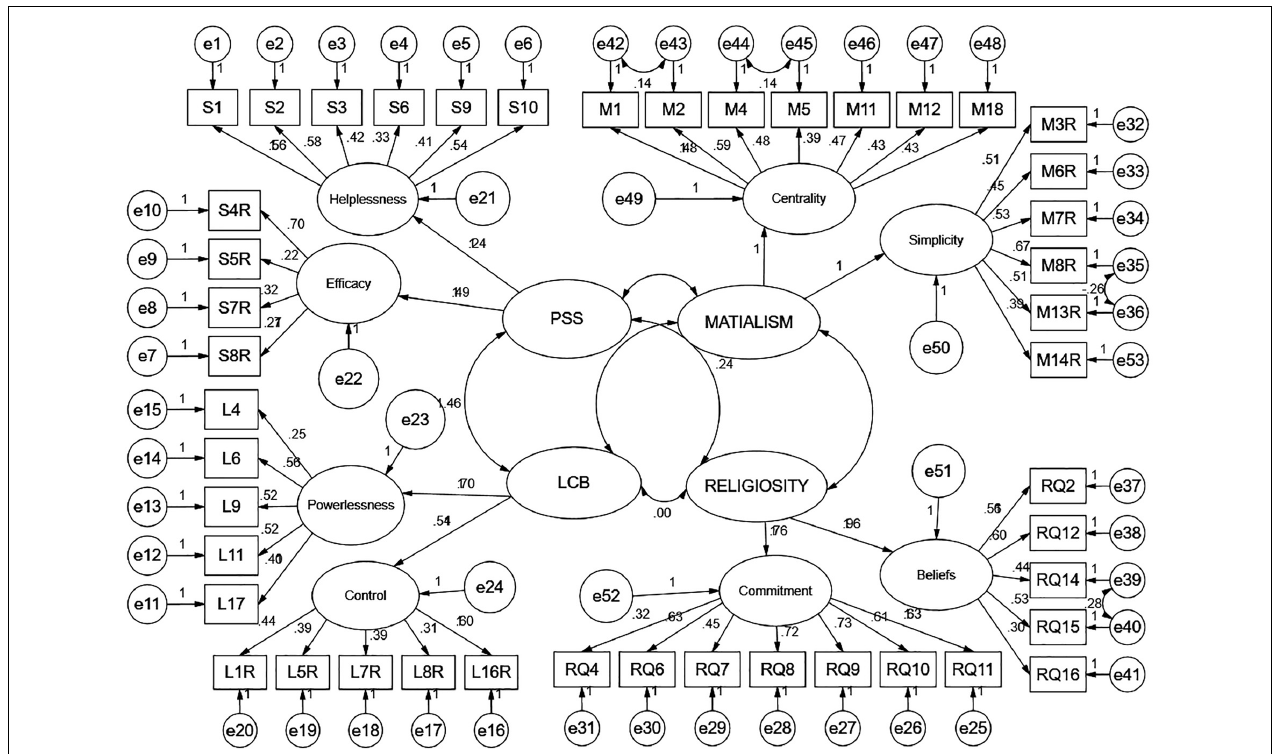
FIGURE 1 | Recursive model of second-order formative constructs. Minimum iteration was achieved; chi-square = 6295.60; degrees of freedom = 2,793; and probability level = 0.001.